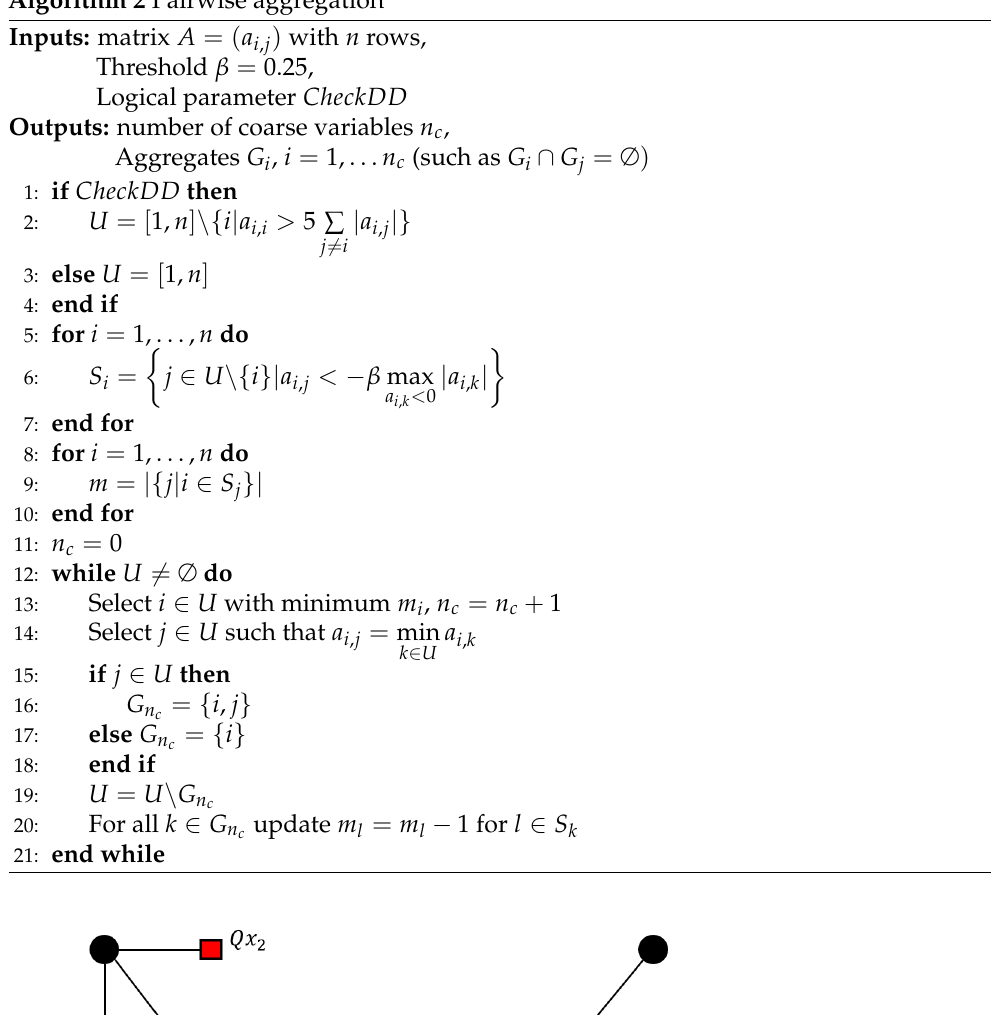
Algorithm 2 Pairwise aggregation